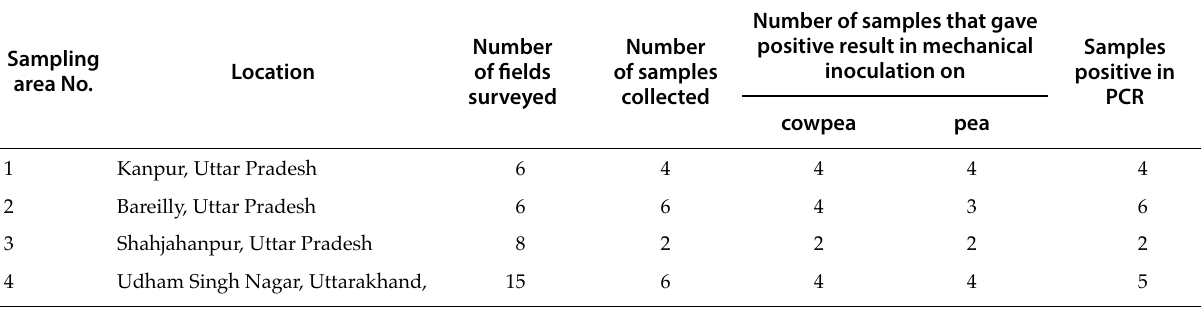
Table 2. Details of survey and detection of GBNV in field infected pea samples.